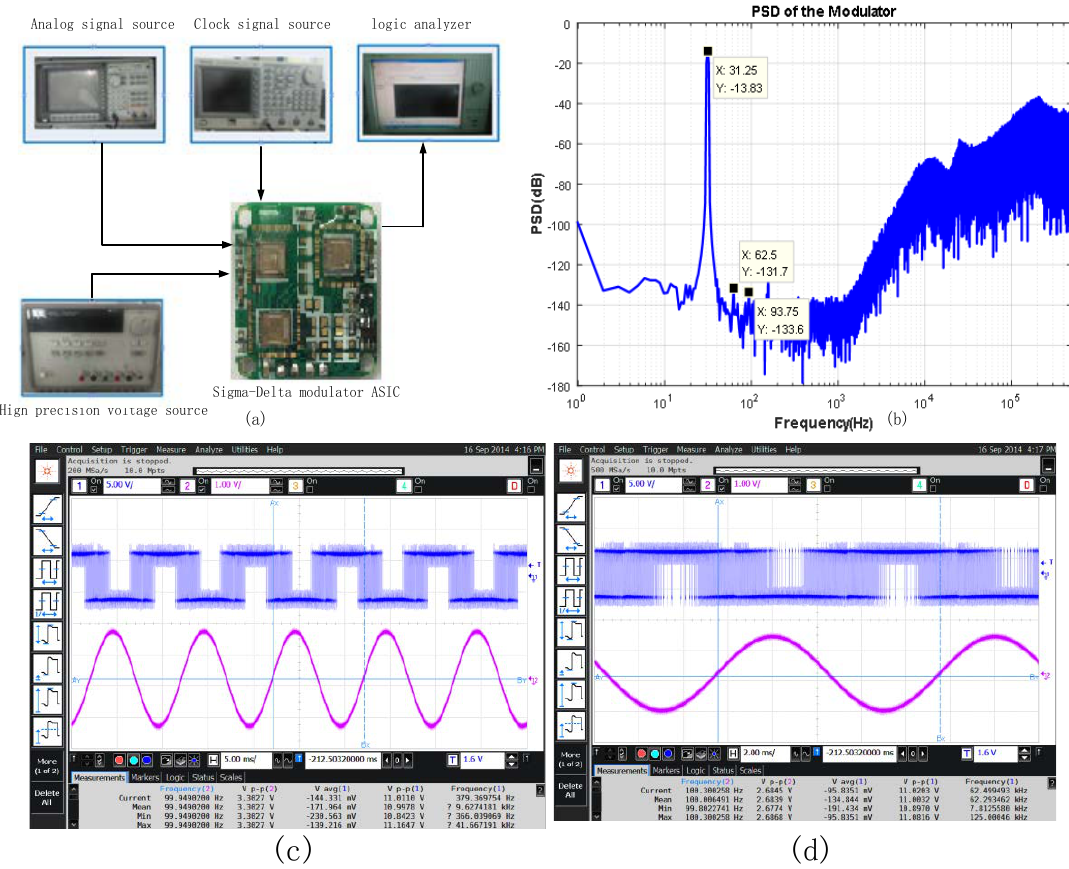
Figure 8. ( a ) The testing system of Sigma-Delta modulator Application Specific Integrated Circuit (ASIC); ( b ) The PSD of Sigma-Delta modulator; ( c ) The transient response of Sigma-Delta modulator; and, ( d ) Transient response after local amplification.